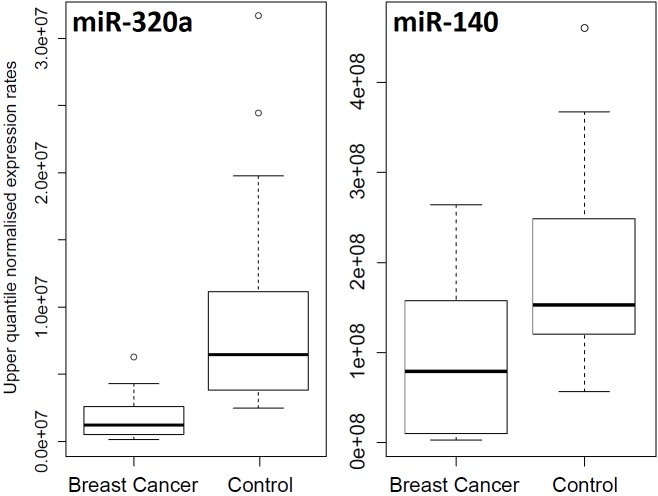
Differential analysis of miRNA between breast cancer and control groups.The distribution of miR-320a and miR-140 upper quantile normalised expression levels between the breast cancer and control groups from Illumina reads. Note that the y-axes are different for each miRNA because of the differing scales.